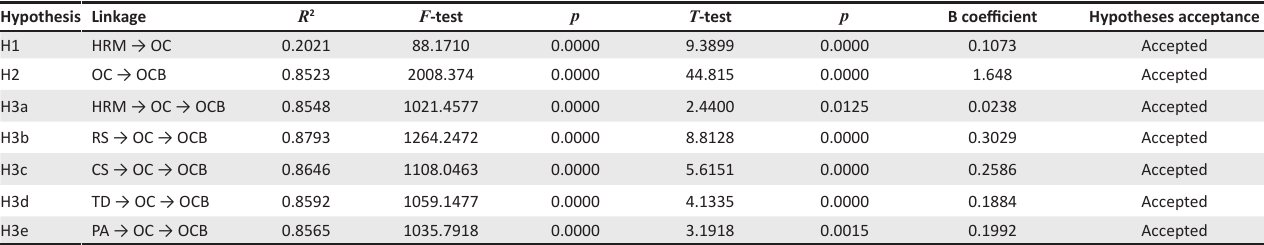
TABLE 7: Result of hypothesis testing. Hypothesis